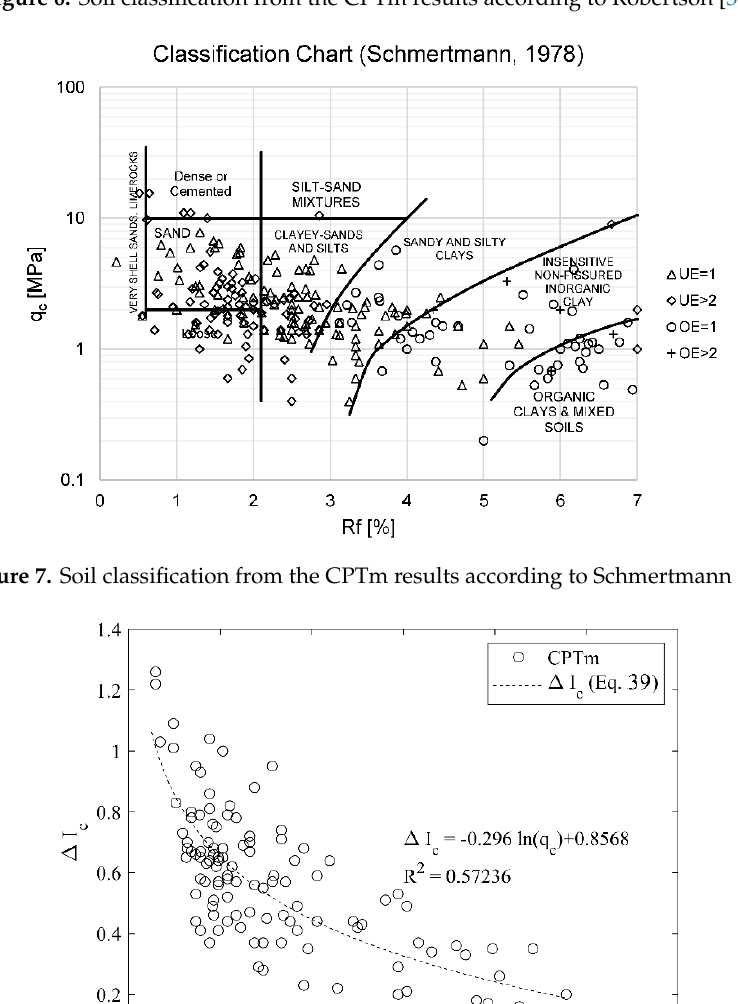
Figure 6. Soil classification from the CPTm results according to Robertson [38].